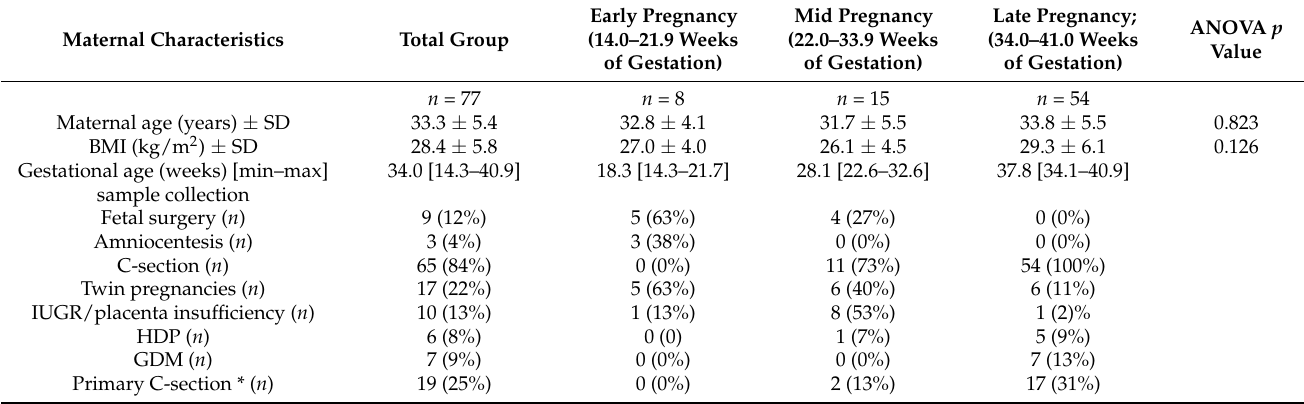
Table 1. Study characteristics.